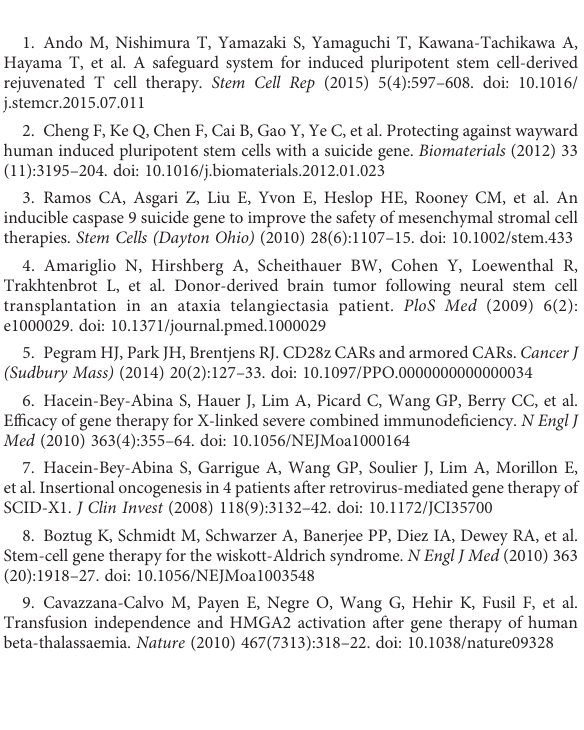
SUPPLEMENTARY FIGURE 1 Expression of the selectable marker on days 1and 14 after killing from one representative experiment using Jurkat expressing D iC8-RQR8, Rapa. D iC9- D CD19 or both, treated with the BB homodimerizer [100nM], sirolimus (siro) [25 ng/mL] or